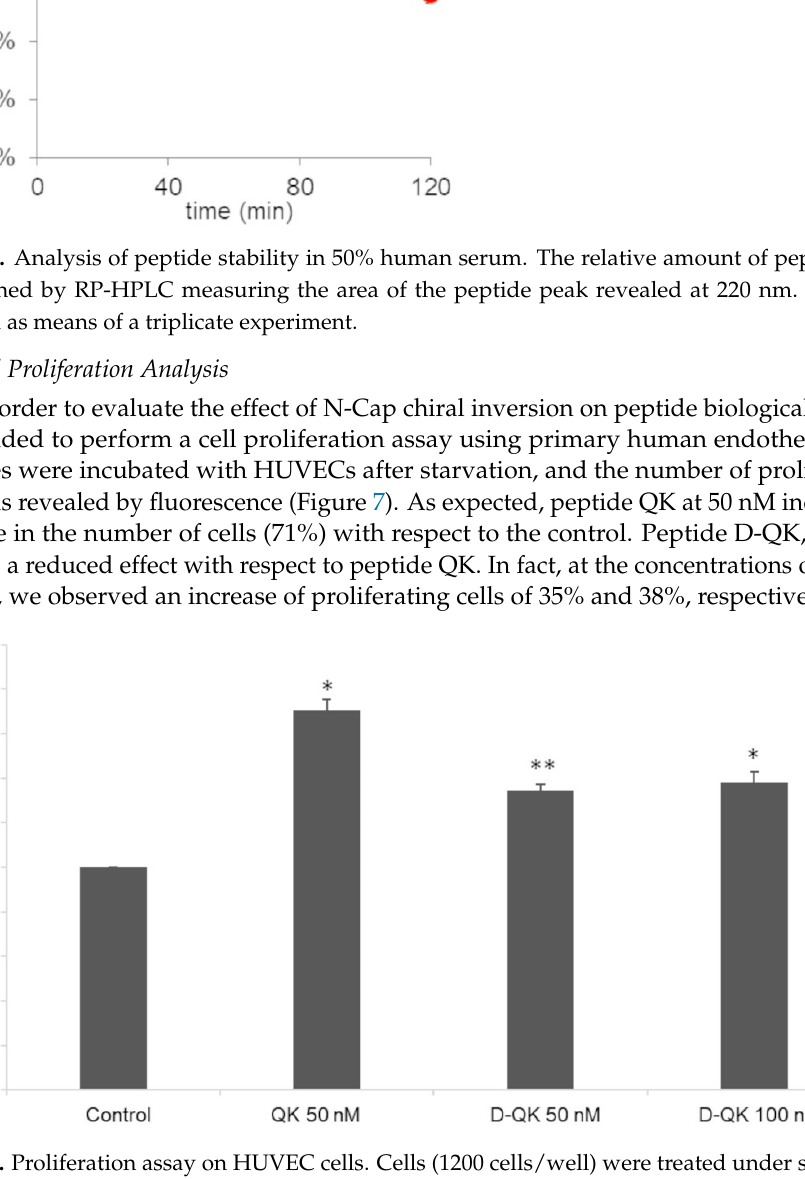
Figure 7. Proliferation assay on HUVEC cells. Cells (1200 cells/well) were treated under starvation conditions for 6 h and incubated with peptides at indicated concentrations for 24 h. Data are expressed as the percentage of proliferating cells with respect to the control (untreated cells) and are expressed as means ± SE of at least three independent experiments (* p < 0.05; ** p < 0.01).